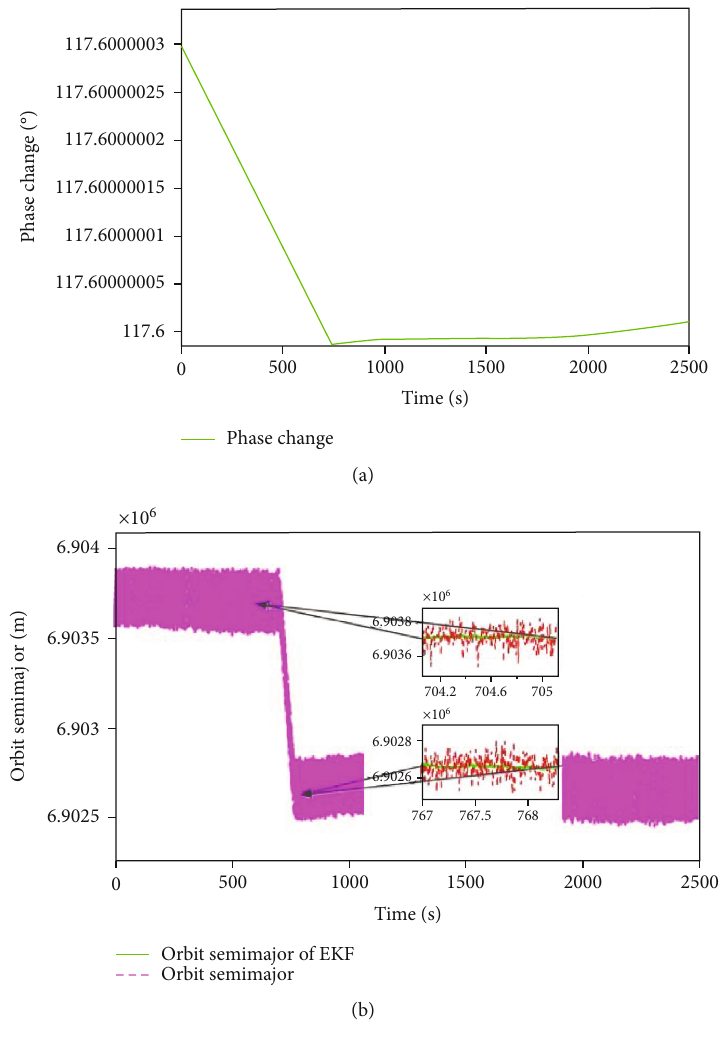
Figure 6: State change of the satellite. (a) The phase. (b) The orbit